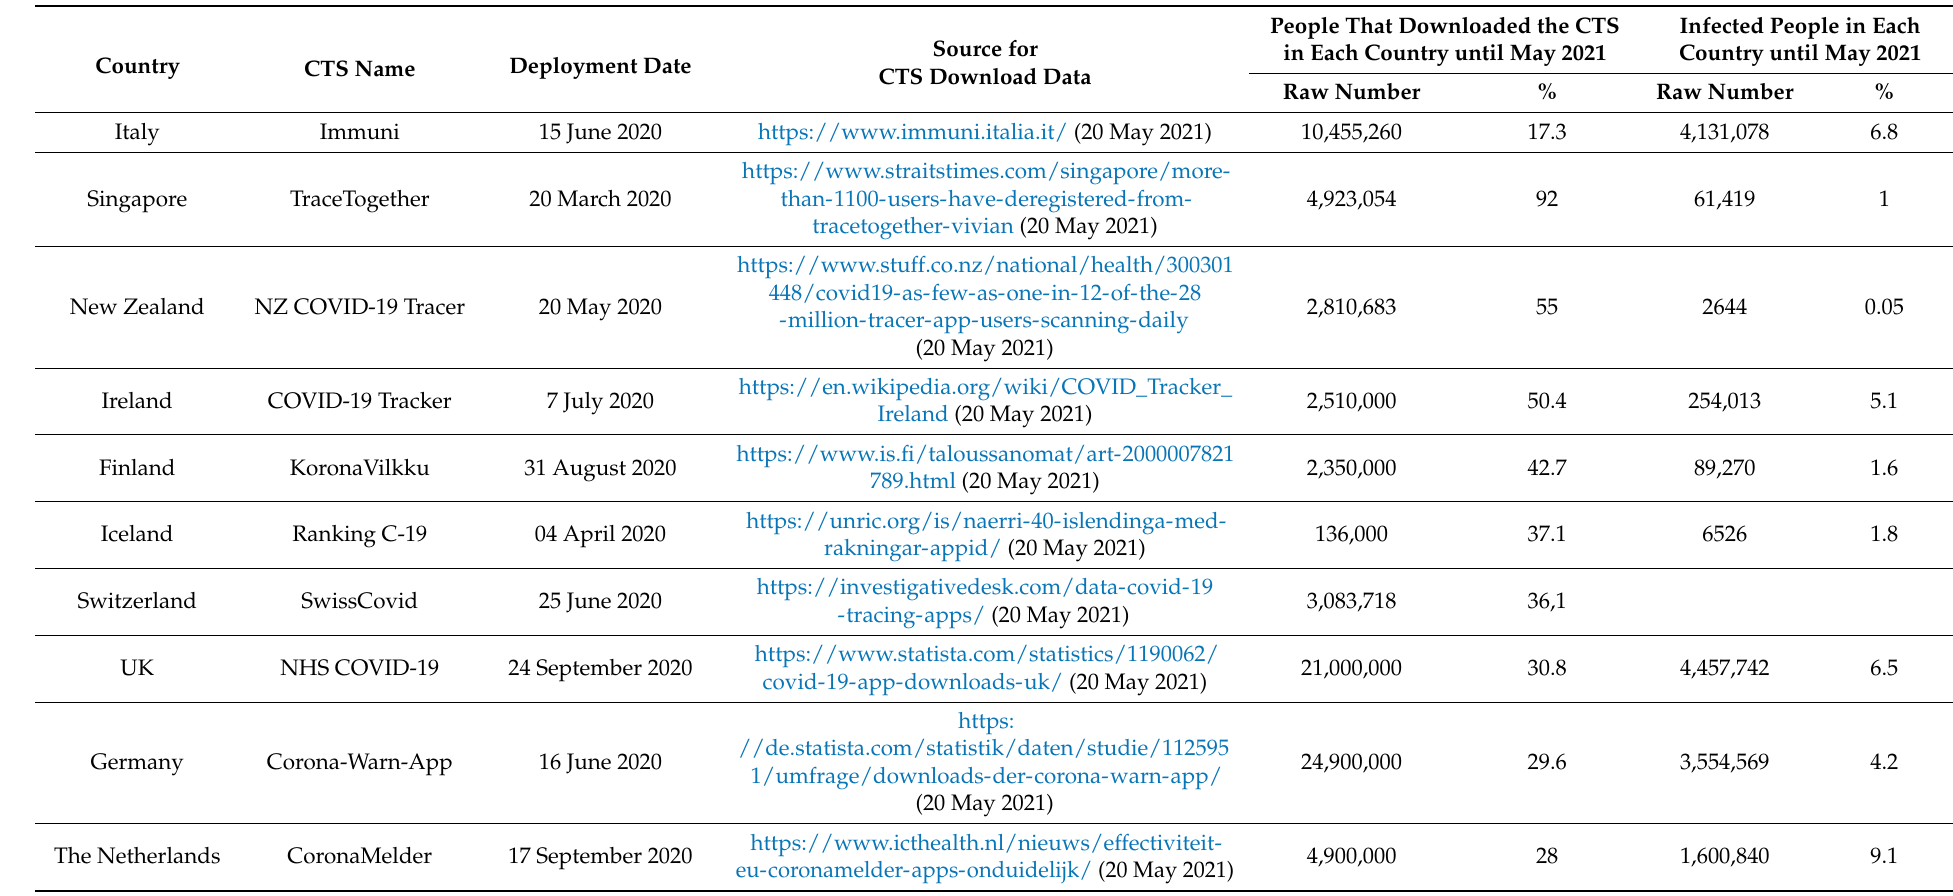
Table A1. Contact Tracing Systems worldwide. The Table reports the information regarding the CT system used, the number of people that downloaded it, and the number of infected people in each country until May